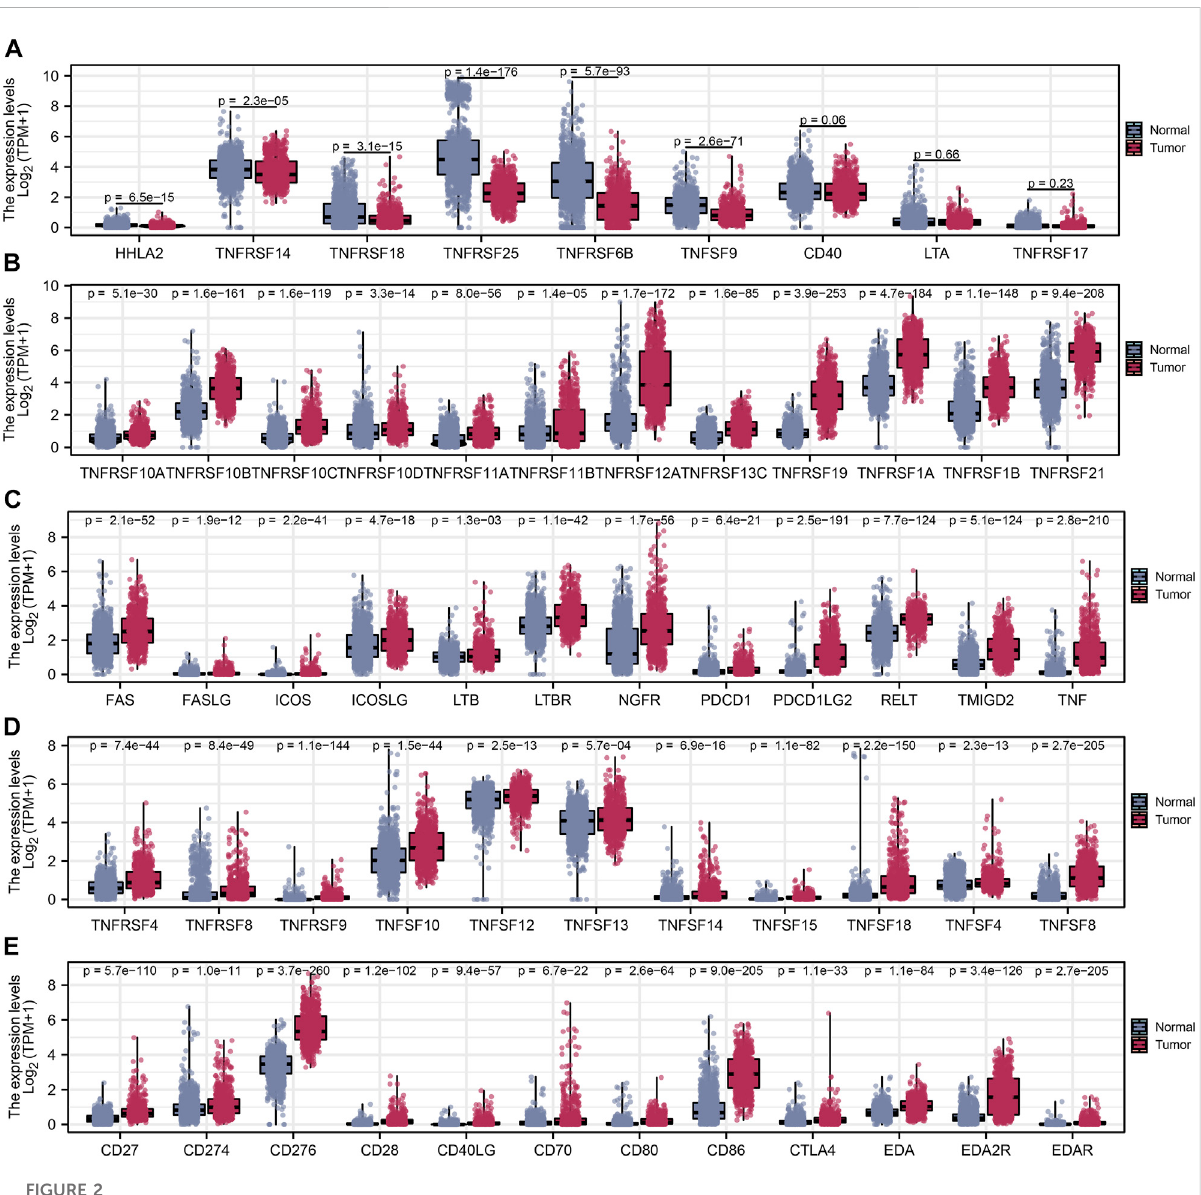
FIGURE 2 Differential expression analysis of costimulatory molecules. (A) Six costimulatory molecules HHLA2, TNFRSF14, TNFRSF18, TNFRSF25, TNFRSF6B, and TNFSF9 were underexpressed in tumor samples. (B – E) The other 48 costimulatory molecules were highly expressed in tumor